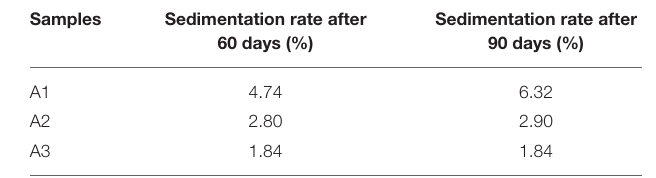
TABLE 2 | Comparison of the magnetic property of two types of magnetic particles. Particles